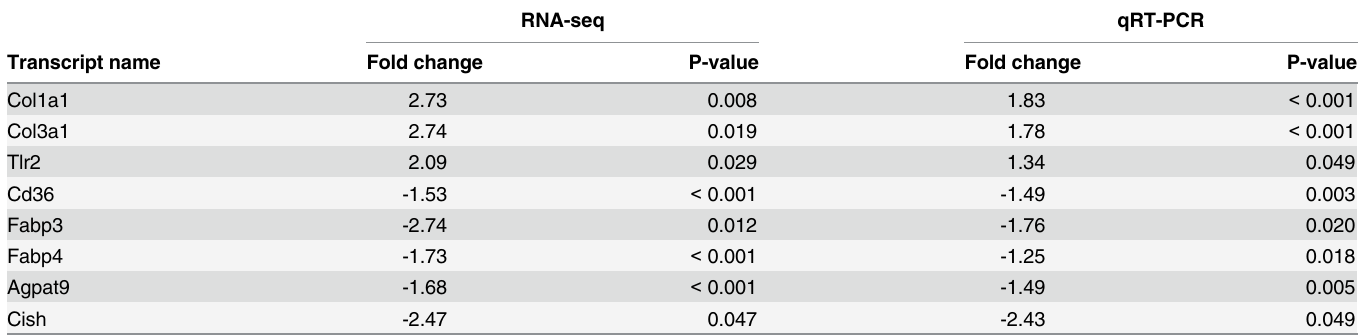
Table 8. Validation of select RNA-seq transcripts by